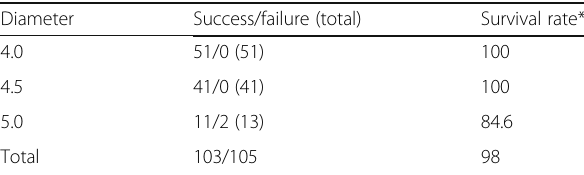
*Survival rate results were not significant among the three diameter